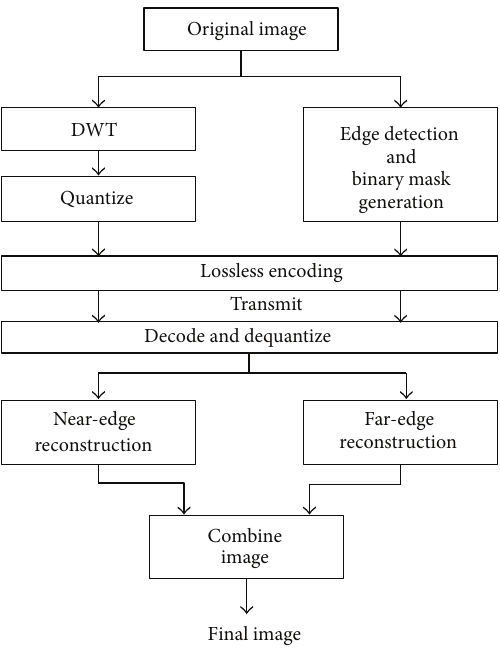
Figure 4: GA for evolving wavelet filter coefficients (Salvador et al., [7]). Figure 5: Image decomposition and reconstruction with evolved filters targeting edge-adjacent and non-edge-adjacent portions of image (Peterson and Lamont